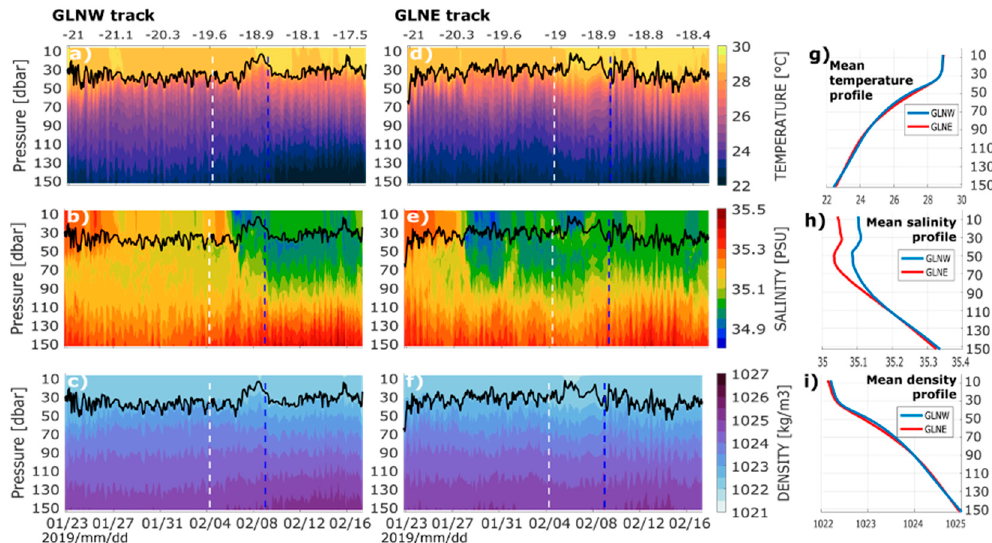
Figure 13. Time series of vertical temperature (top), salinity (middle), and density (bottom) profiles within the top 150 m ocean layer from 23 January 2019 to 17 February 2019 for ( a – c ) GLNW and ( d – f ) GLNE tracks. Panels ( g – i ) show the associated mean vertical profiles over the same period. The vertical white dashed line in ( a – f ) indicates the date of formation of the Tropical Cyclone GELENA (4 February). The vertical blue dashed line shows the closest position of each glider to the TC core (around 9 February). The top axis indicates the latitudinal location of the profiles.